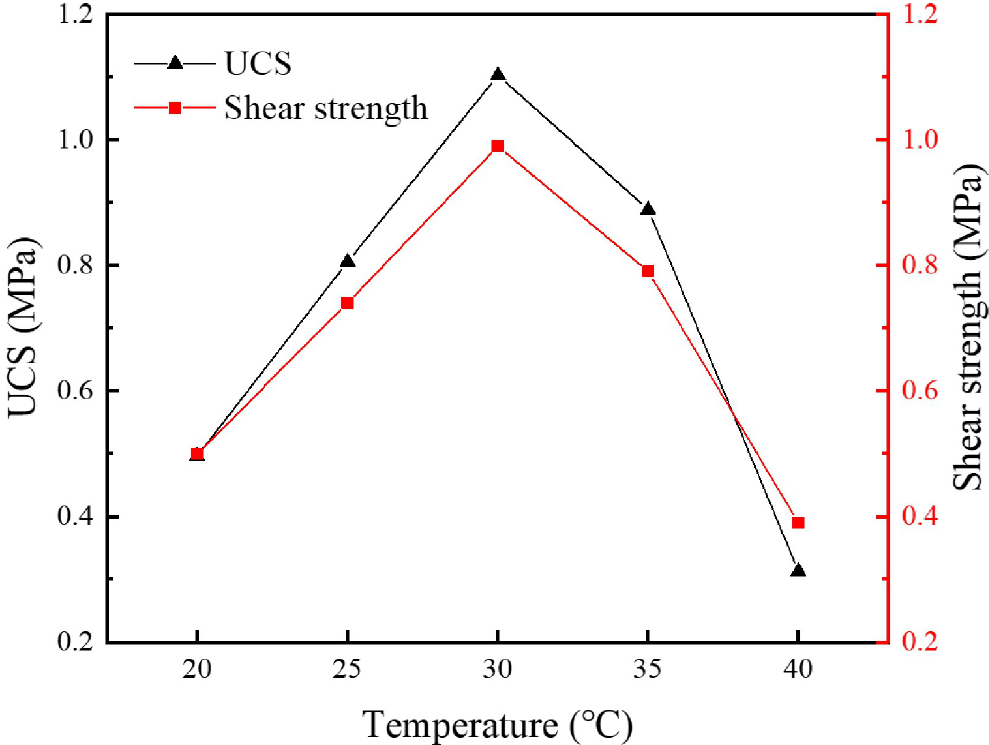
Fig 16. Relationship between curing temperature and mechanical